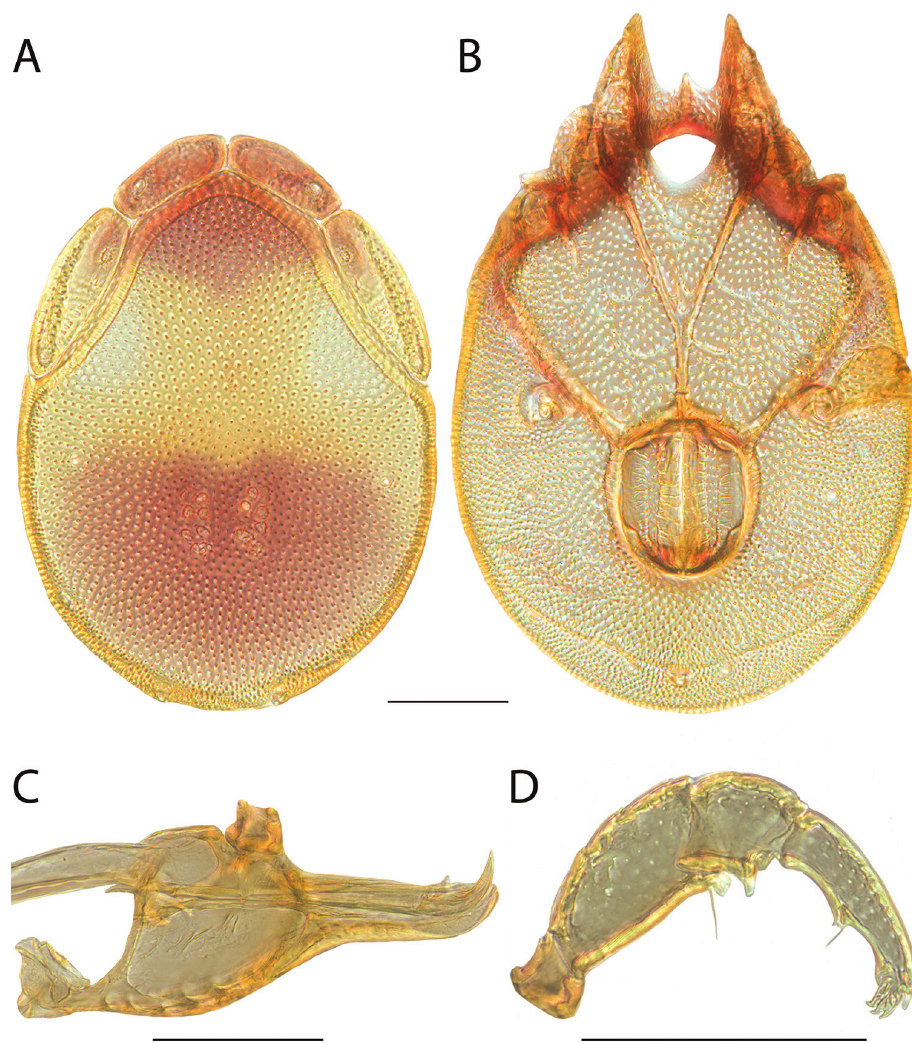
Figure 245. Torrenticola skvarlai sp. n. male: A dorsal plates B venter (legs removed) C subcapitulum D pedipalp (setae not accurately depicted). Scale = 100